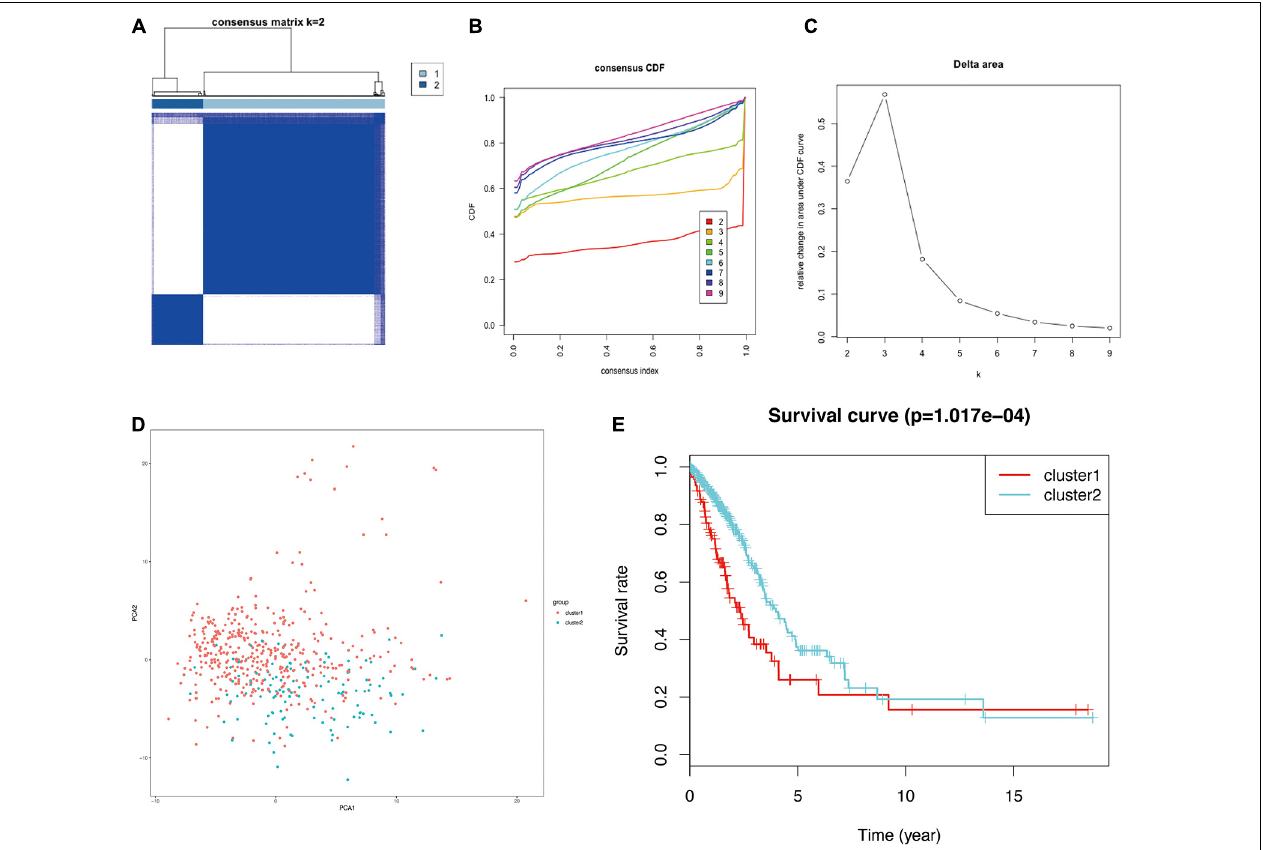
FIGURE 4 | Identification of consensus clusters of glycolysis-related genes in LUAD from the TCGA database. (A) Consensus clustering matrix for k = 2. (B) Consensus clustering CDF for k = 2–9. (C) Relative change in the area under the CDF curve for k = 2–9. (D) PCA of the 43 glycolysis-related genes in LUAD. (E) Survival curves of each cluster in LUAD. LUAD, lung adenocarcinoma; TCGA, The Cancer Genome Atlas; CDF, cumulative distribution function; PCA, principal component analysis.